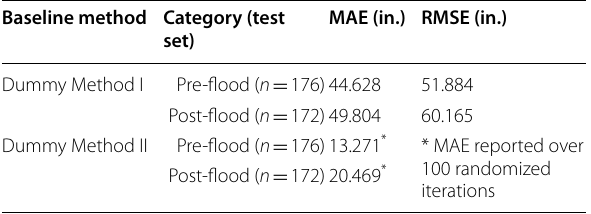
Table 5 Performance of dummy methods I and II on the test set